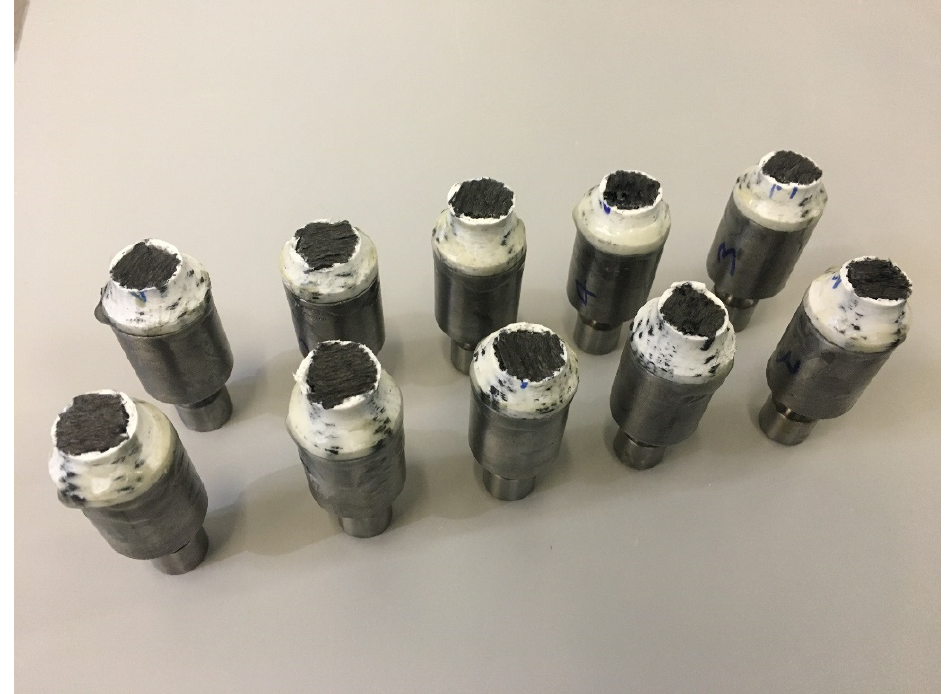
Figure 5. Fracture samples after testing with a consistent failure region. Another standard that is used to determine the strength and modulus is ASTM C 297. Strain gauges were bonded to the specimen to measure the elastic modulus correctly.